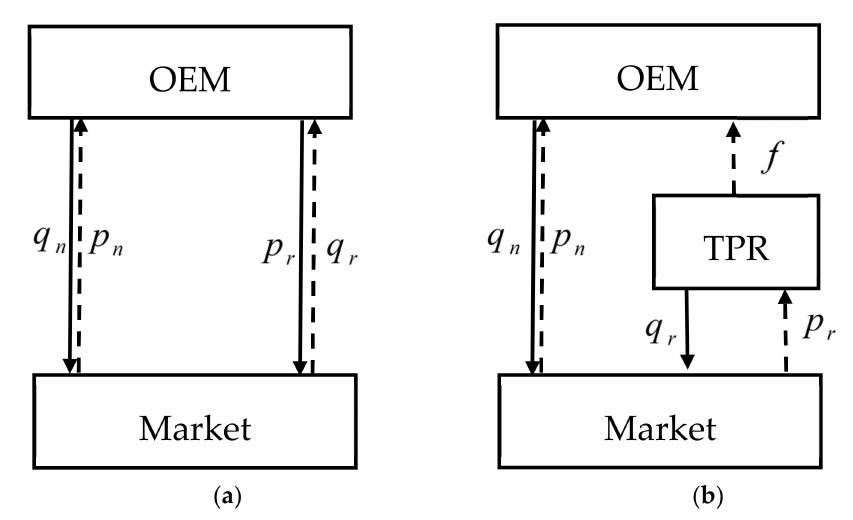
Figure 1. Two channel structures: ( a ) Model O and ( b ) Model